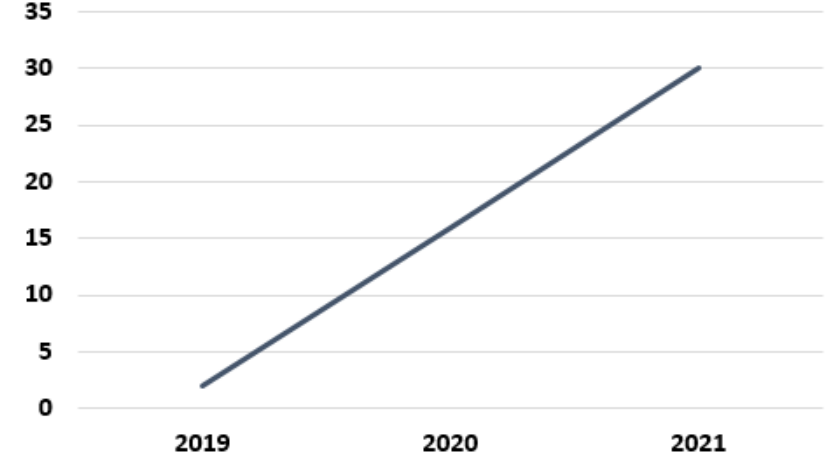
Figure 2. Articles by publication year.